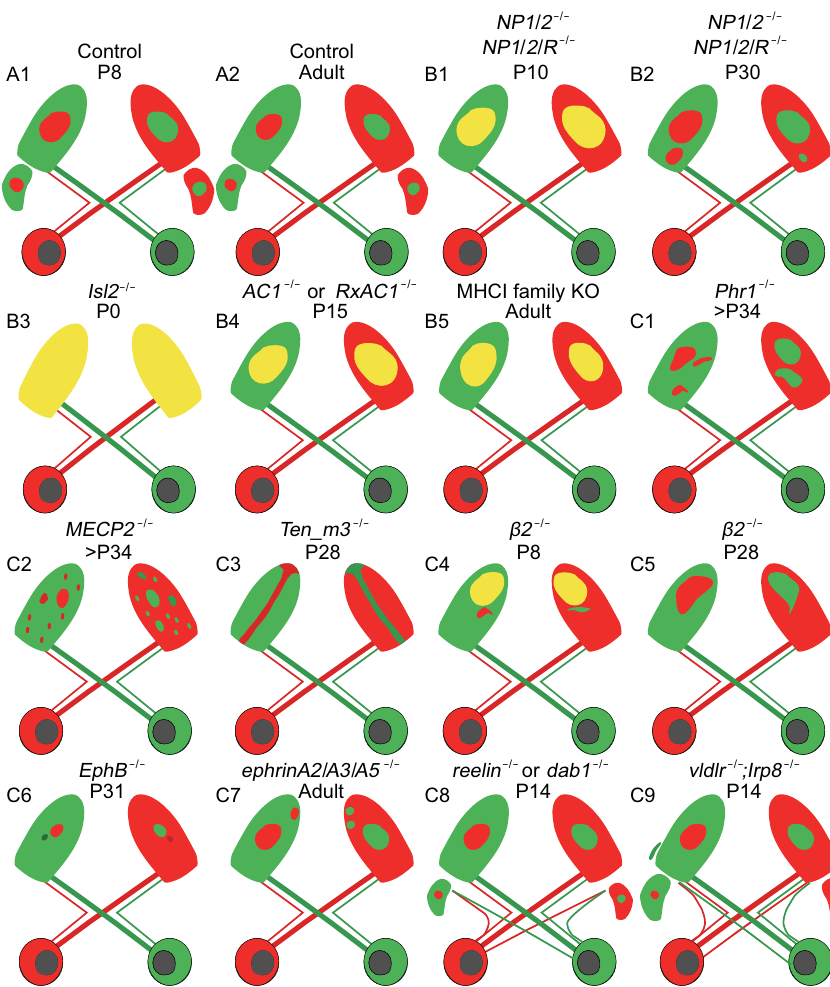
Figure 4. Schematics of genes and molecules involved in the retinal axon targeting and eye-speci fi c segregation in the dLGN. (A1 – 2) Development of RGC axons targeting in the dLGN in control mice. (B1 – 5) Mice with increased overlap projections in the dLGN. (C1 – 9) Abnormal ipsilateral projection in the